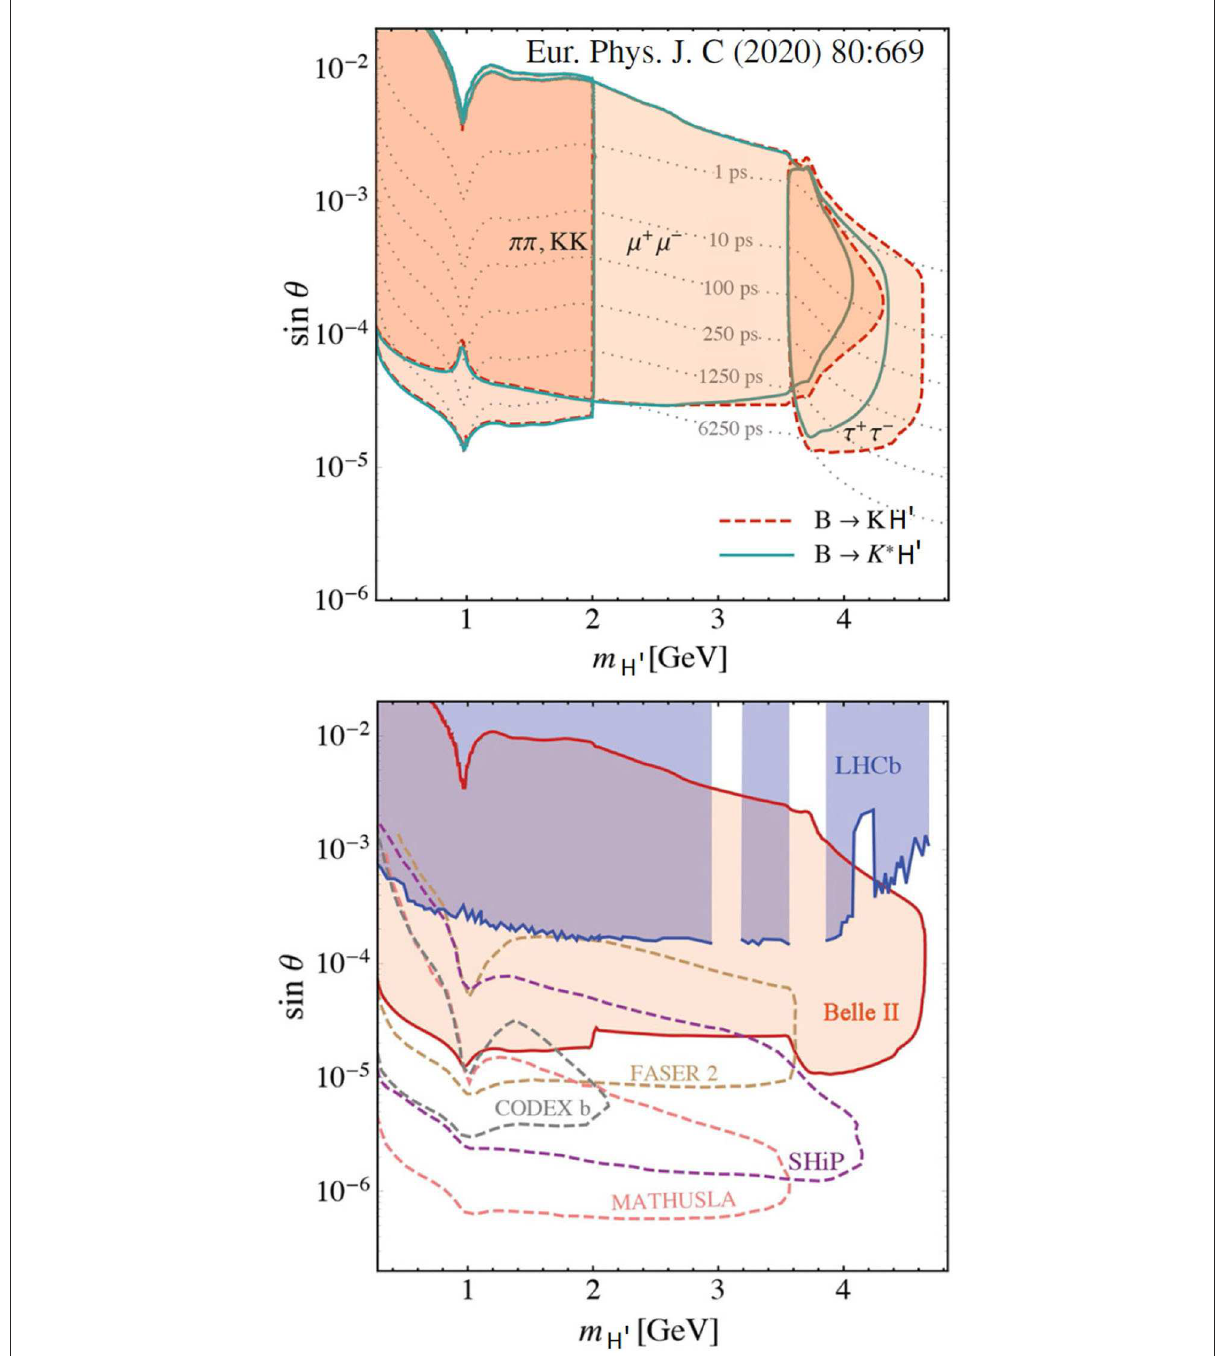
FIGURE8 Parameter space regions for the B future experiments (bottom) , (Figures adapted from Kachanovich, Aliaksei et al.,